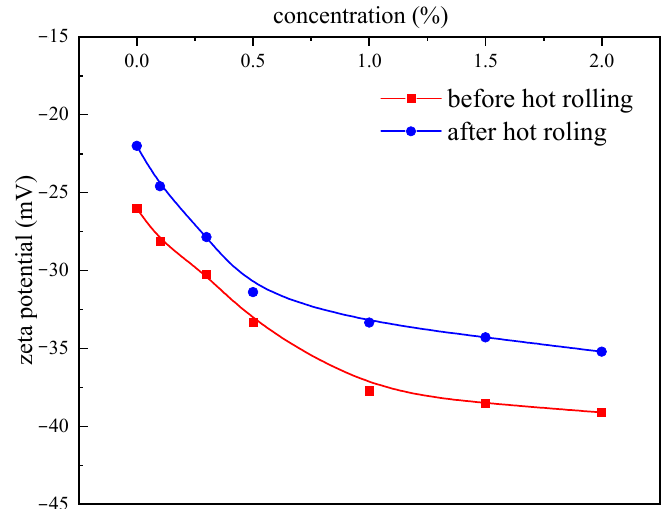
Figure 14. Effects of different concentrations of PAASM-CaCO 3 on zeta potential.